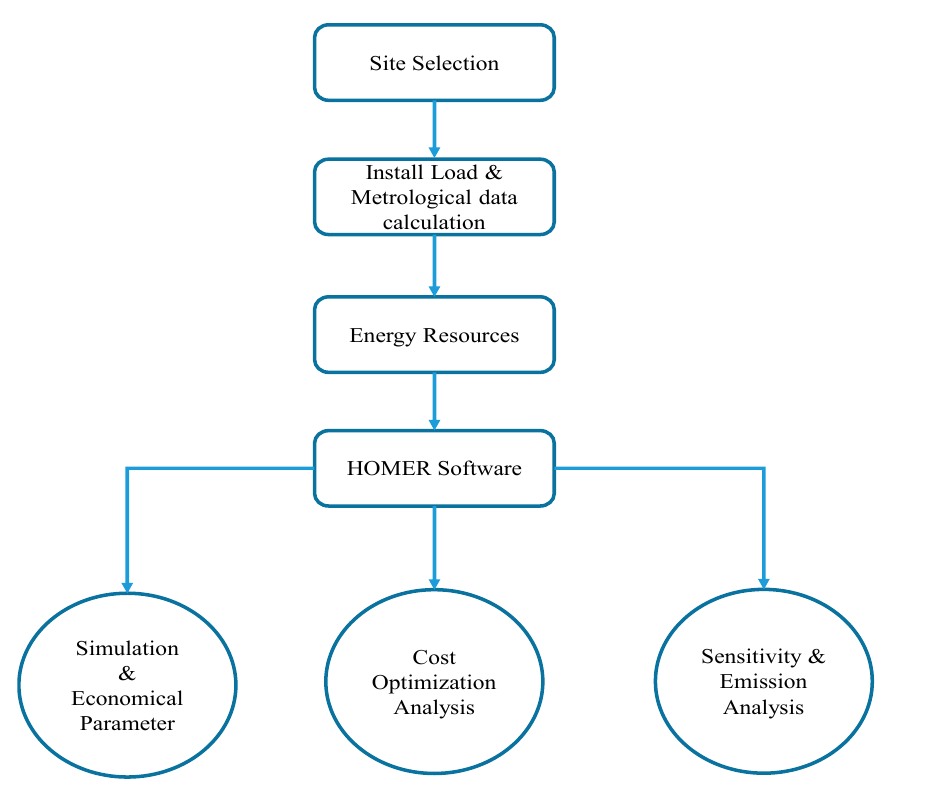
Figure 1. Flow chart of research methodology.